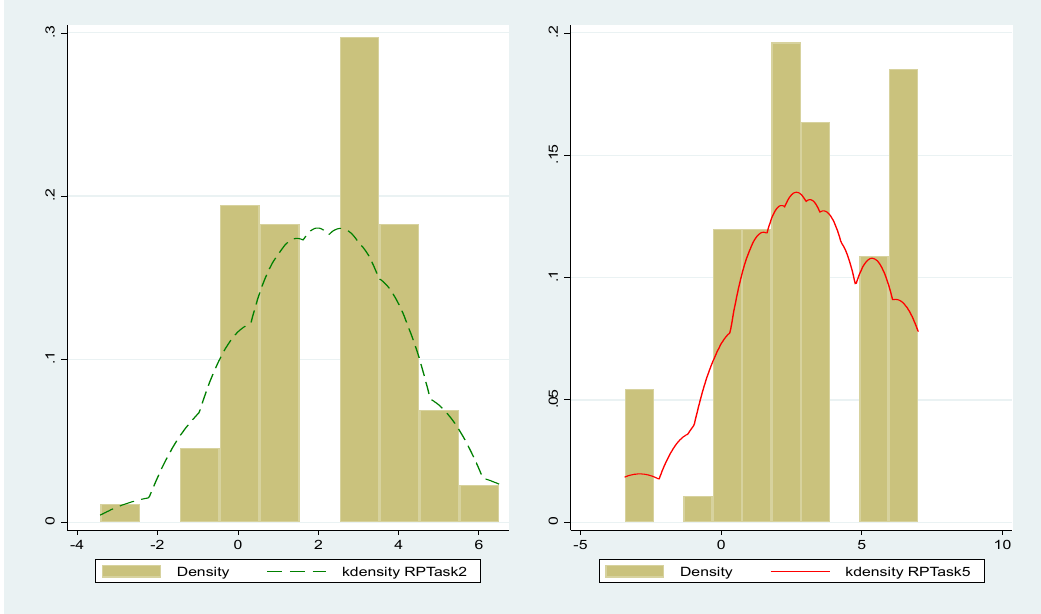
Figure 7. Histograms and kernel densities of the PaRP and the PrRP exhibited by the subjects.